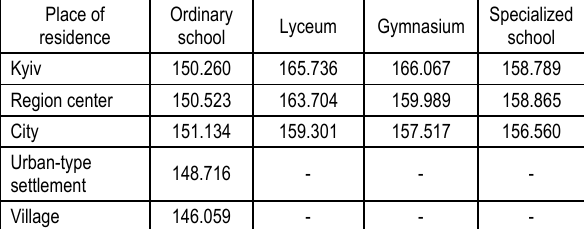
Table 1. Average score of